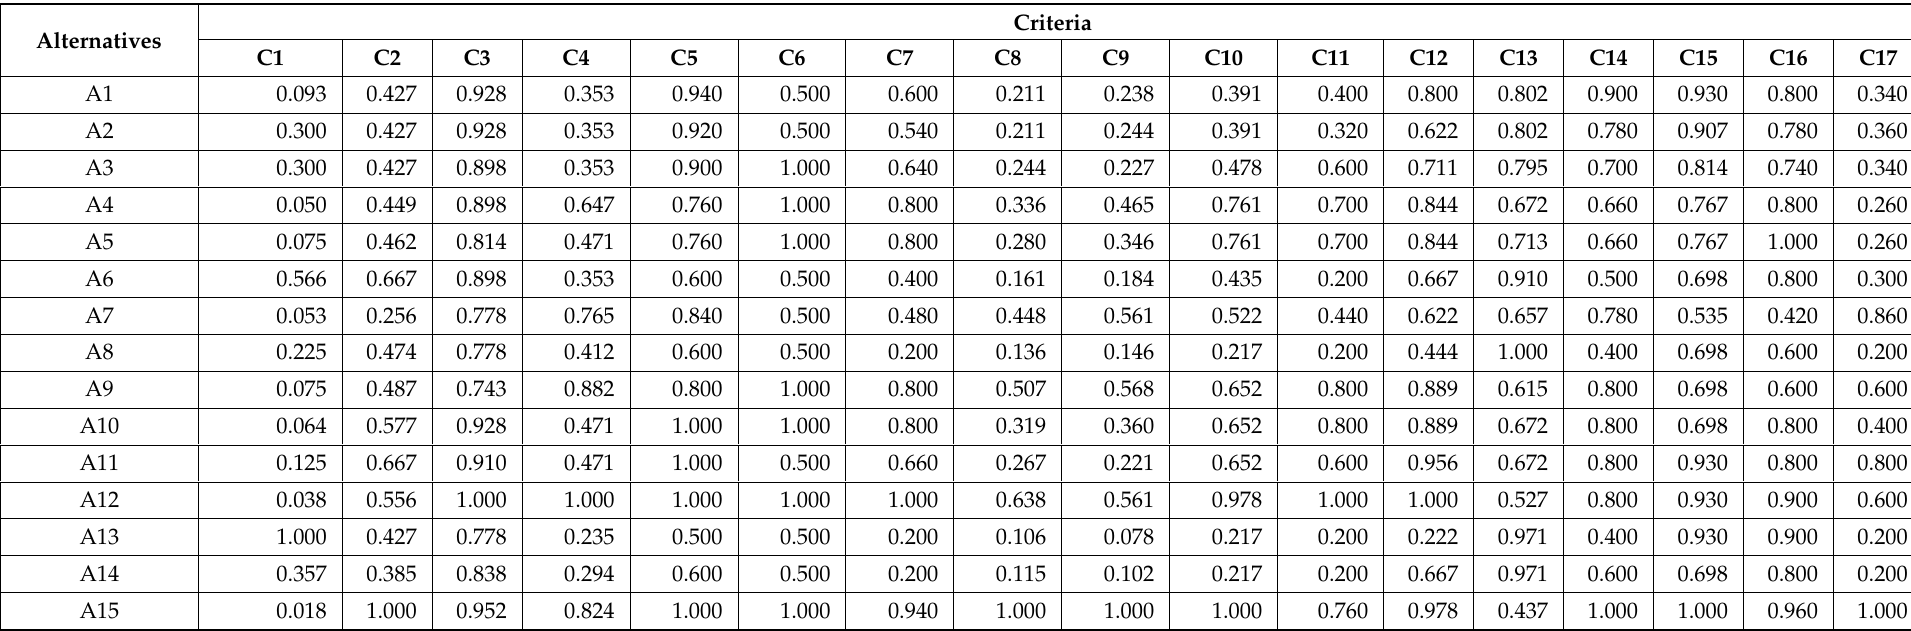
Table 3. Aircraft evaluation matrix concerning criteria with normalized values.